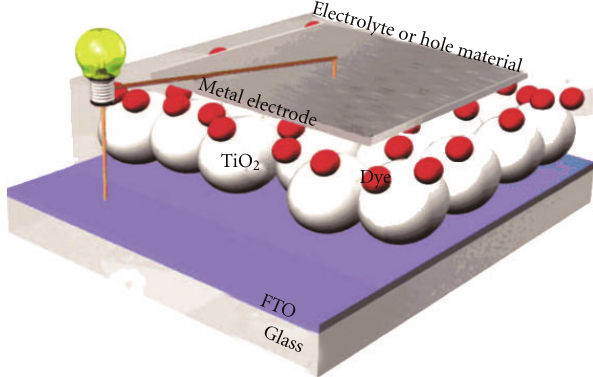
Figure 1: Diagram of typical dye-sensitized solar cell (taken from